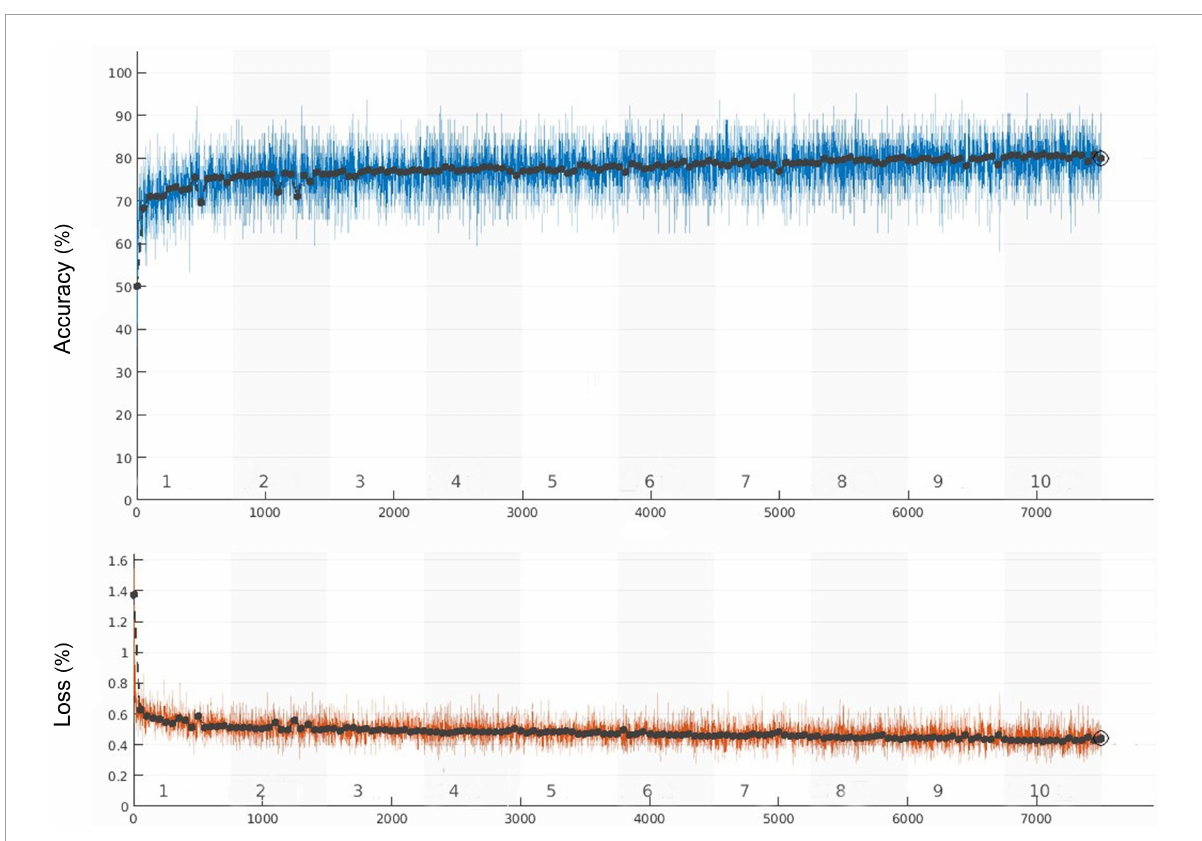
FIGURE3 Training accuracy and training loss curves (the black curve and blue curve represent the accuracy of training set and verification set, respectively, the orange curve represents the loss).